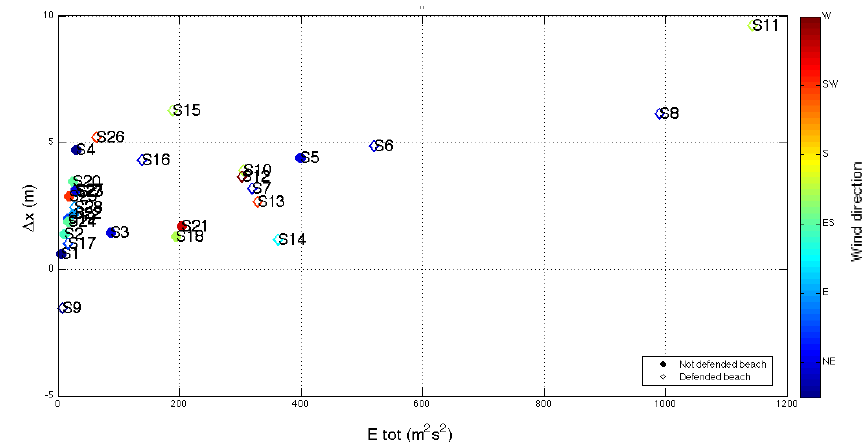
Figure 14. Relationship between total wave energy and shoreline displacement.